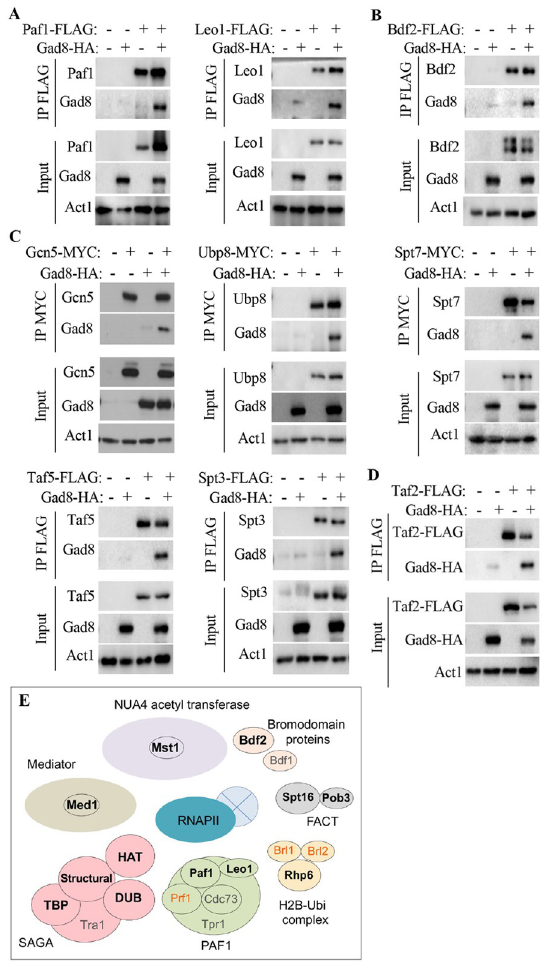
Fig 1. Gad8 associates with transcription and chromatin-modification factors. Gad8 associates with subunits of Paf1C ( A ) Bdf2 ( B ) subunits of SAGA ( C ) and with Taf2, a subunit of TFIID ( D ). Protein extracts from wild type cells expressing the indicated chromosomally tagged proteins were immunoprecipitated (IP) with anti-MYC or anti-FLAG antibody. Western blots were performed using either anti-HA, anti-FLAG or anti-MYC. The expression levels of the indicated proteins before IP is shown (Input). Act1 was used as a loading control. ( E ) A schematic presentation showing proteins that physically interact with Gad8. Bold letters: positive interactions, grey letters: failure to detect interaction and orrange letters: failure to express the tagged protein. Notably, all proteins that interacts with Gad8 are closely associated with RNA Pol II. The light blue circle represents a